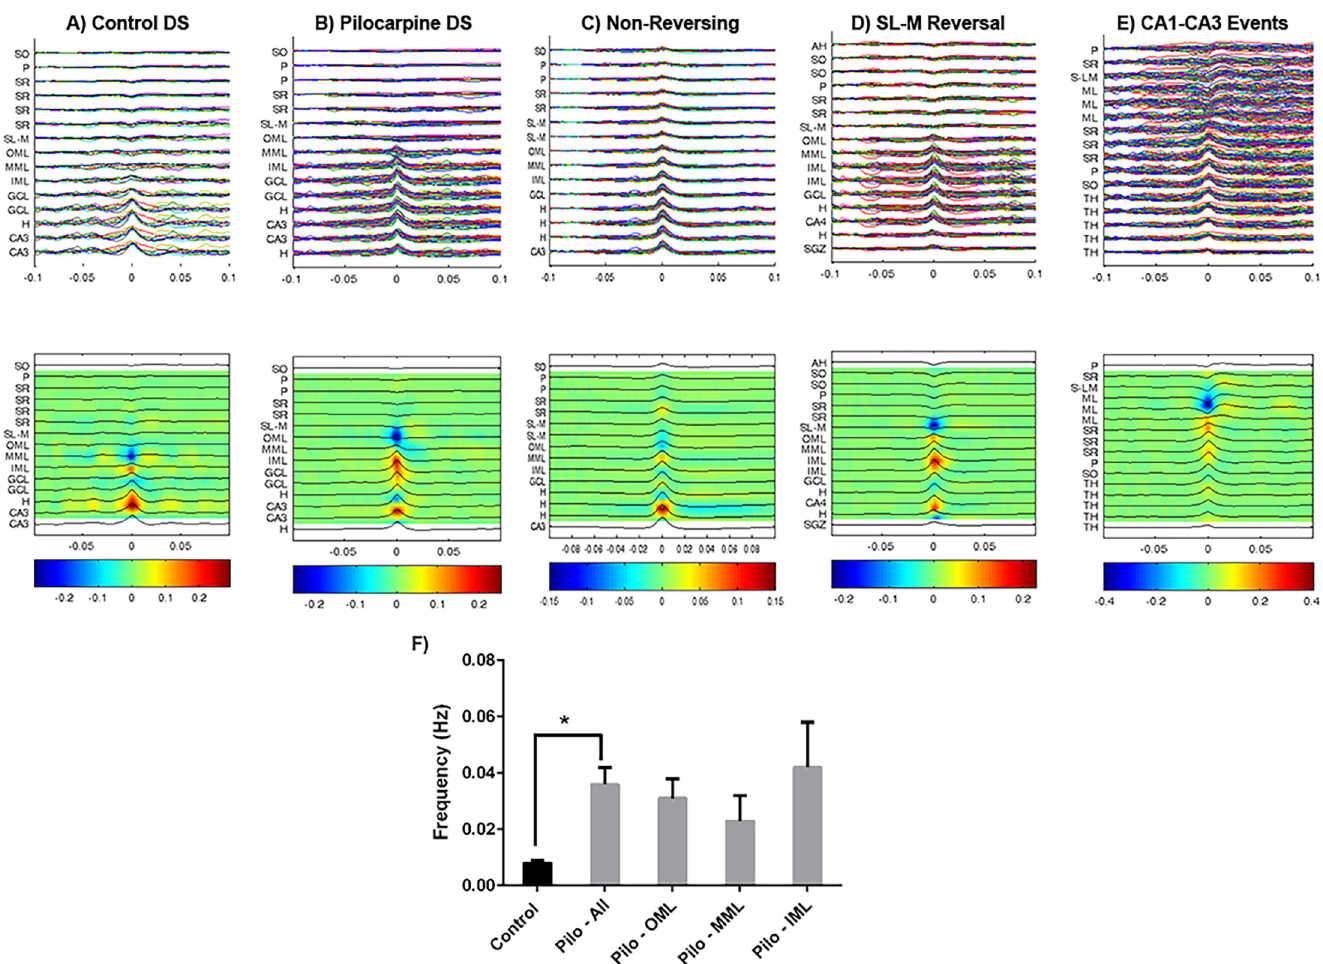
Fig 3. Waveform and CSD plots of identified spikes in control and pilocarpine-treated animals. In the top panel all individual events were overlaid and aligned to the peak spike amplitude. In the bottom panel an average of the EEG traces was shown overlaid on a CSD plot displaying current sinks (blue) and current sources (red). In both panels on the y-axis the anatomical location of each of the 16-laminar (100 μ m spacing) EEG traces was shown. A) DS observed in control animals (n = 8 spikes), B) Pilocarpine-induced DS (n = 40), C) Non-Reversing spikes in the CA1-DG plane (n = 58), D) Population events with a reversal in CA1 SL-M (n = 35) E) Events recorded in the CA1-CA3 pane (n = 47). F) Frequency of all DS in control (black) and pilocarpine (grey) treated animals. Frequency of DS in pilocarpine-treated animals was further segregated based on location of current sink in the dentate molecular layer. No significant difference was observed between the frequencies of DS at each layer of the molecular layer. SO – stratum oriens, P – CA1 pyramidal cell layer, SR – stratum radiatum, SL-M – stratum lacunosum moleculare, OML – outer molecular layer of the dentate gyrus, MML – middle molecular layer of the dentate gyrus, IML – inner molecular layer of the dentate gyrus, GCL – granule cell layer, H – hilus, CA3 – CA3 pyramidal cell layer, AH – above hippocampus, ML – molecular layer, TH –